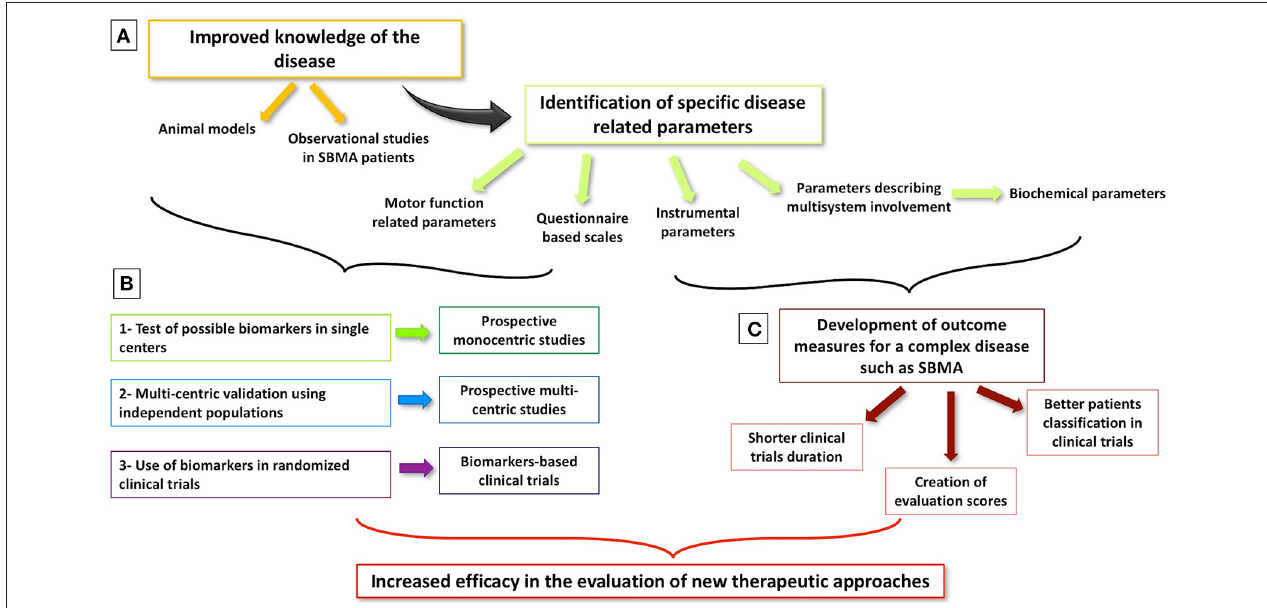
FIGURE 1 | Milestones of biomarker development in SBMA. (A) Better knowledge of SBMA through animal models and observational studies allows the identification of possible biomarkers of disease status and of its progression. (B) Different steps are needed to develop and validate a biomarker in order to make it a reliable outcome measure in clinical trials. (C) Considered the complexity of SBMA and its multi-system presentation, the development of global biomarkers, including both motor function and biochemical parameters, is warranted with the aim of improving the efficacy of upcoming clinical trials.